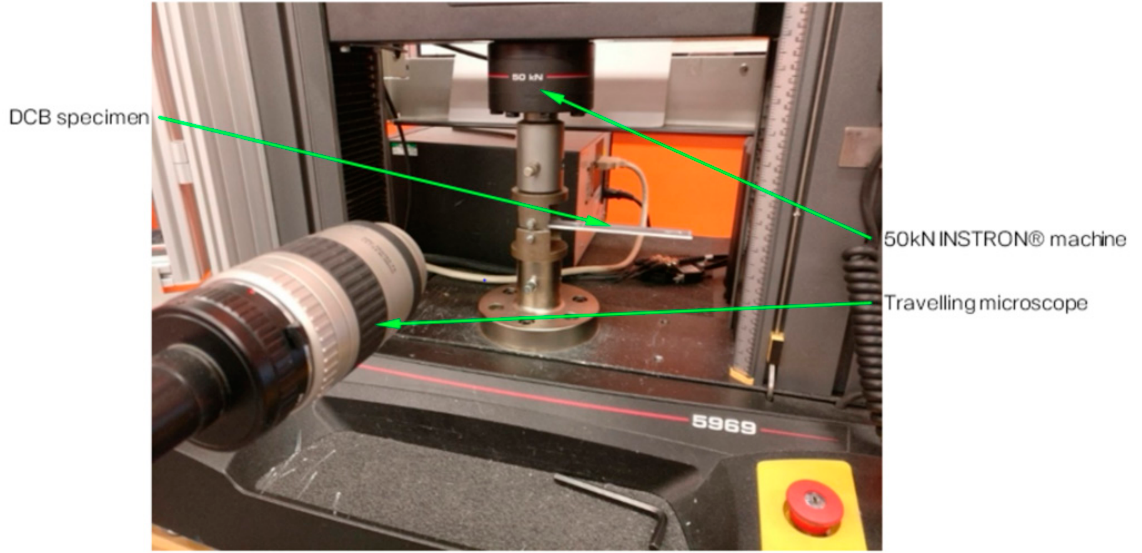
Figure 4. DCB test setup with a travelling microscope, which is a microscope that is mounted on a slider that can be moved along a scale.